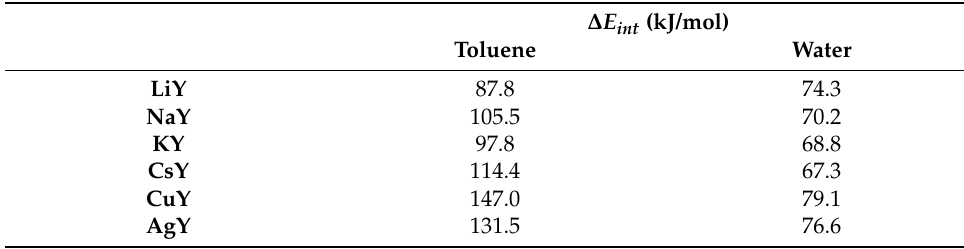
Table 2. Calculated interaction energies (kJ/mol) of toluene and water onto LiY, NaY, KY, CsY, CuY and AgY.